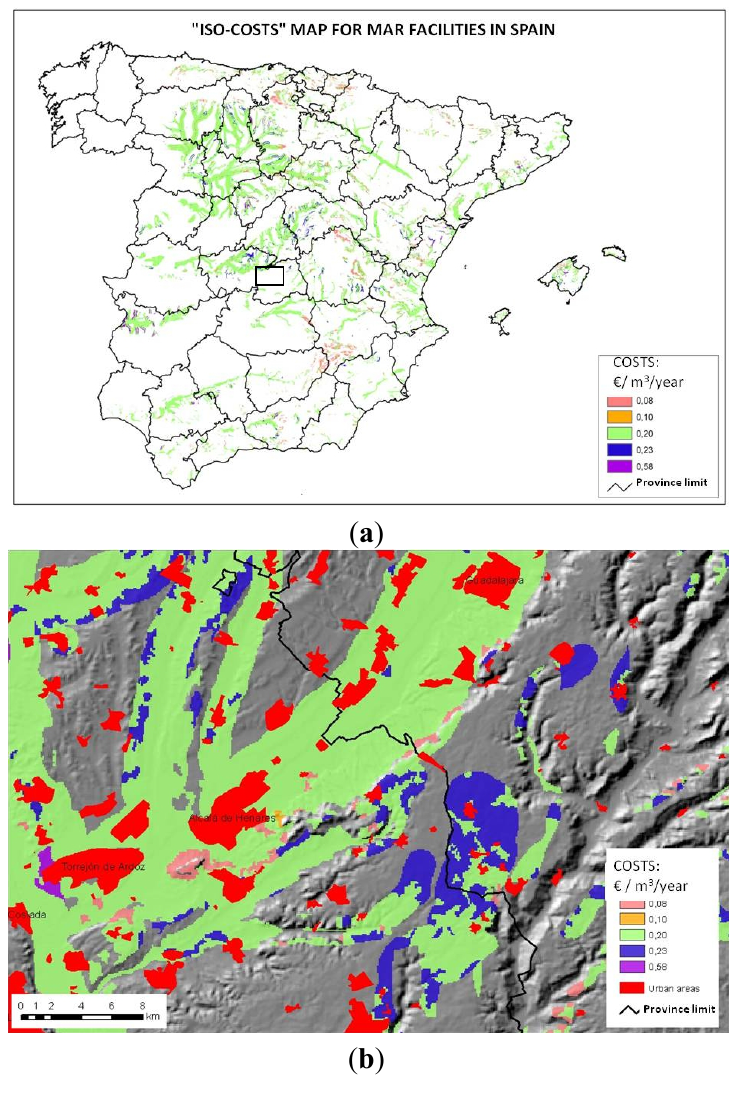
Figure 6. ( a ) Choroplethic map of “iso-costs” for the best MAR facilities in each “MAR Zone” for Spanish Peninsula and Balearic Islands; ( b ) Detailed view for the East of Madrid province (square in Figure 6a). These results are available at DINA-MAR